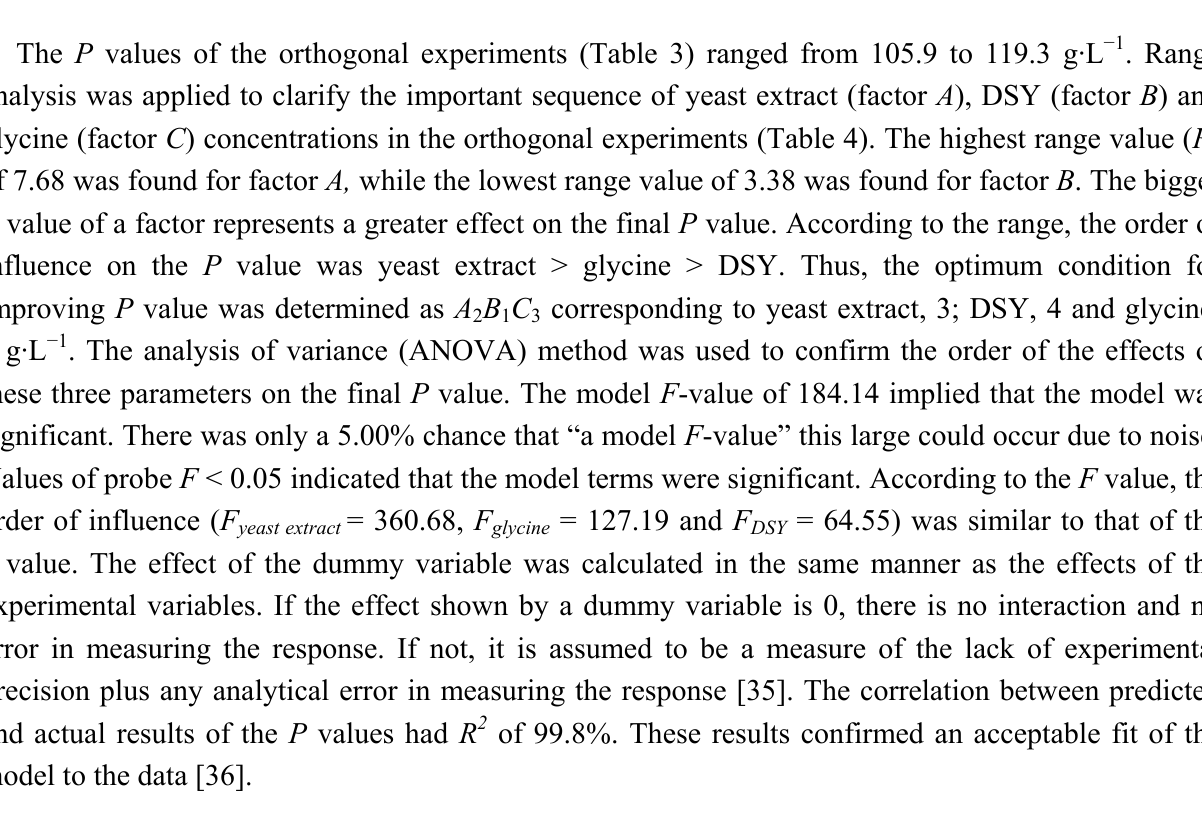
Table 4. The range analysis of L (3 4 ) orthogonal experiment for ethanol concentration ( P ) 9 and productivity ( Q p